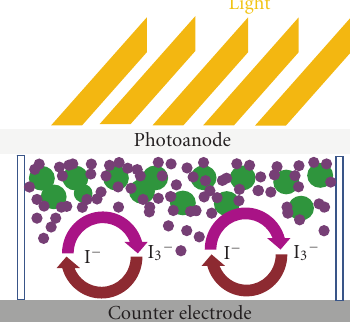
Figure 1: Schematic representation of the structure of a dye sensitized solar cell. The cell has 3 primary parts. On the top is a transparent photoanode made of Indium-doped tin oxide (ITO) deposited on the back of a transparent glass. On the back of the conductive plate is a layer of titanium dioxide (TiO 2 ), which forms into a highly porous structure with an extremely high surface area (green beads). A thin layer of a photosensitive ruthenium- polypyridinedye (purple beads) [55] is covalently bonded to the surface of the TiO 2 . A separate backing is made with a thin layer ) spread over a conductive sheet, of the iodide electrolyte (I − / I − 3 typically platinum metal (the counter electrode). The front and back parts are then joined and sealed together to prevent the electrolyte from